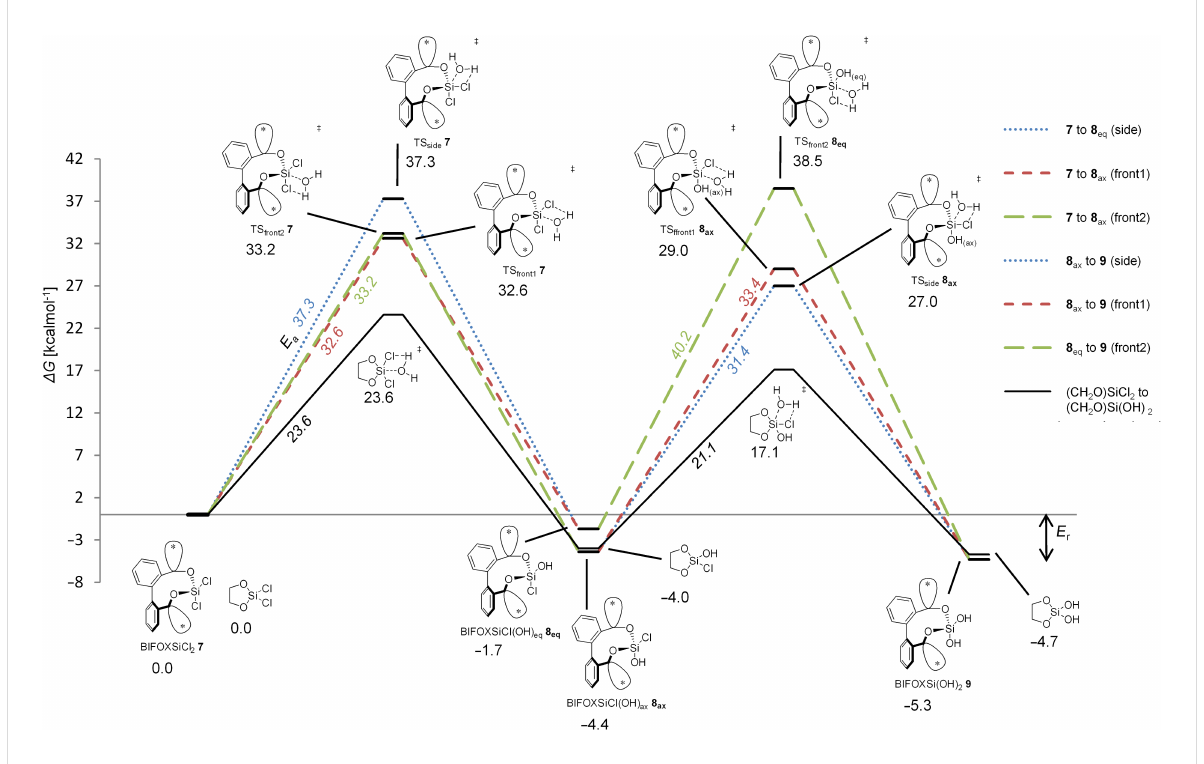
Figure 5: Computed hydrolyses of BIFOXSiCl 2 ( 7 ) to BIFOXSiCl(OH) 8 ax and BIFOXSiCl(OH) 8 eq and subsequent computed hydrolysis to BIFOXSi(OH) 2 ( 9 ) and comparison with glycoxydichlorosilane. The activation energy ( E a ) is the difference of the free Gibbs energy of the educt and the TS and the reaction energy ( E r ) is the difference the free Gibbs energies of the educts and products of the respective steps side and front1 result- ing in BIFOXSiCl(OH) 8 eq , front2 results in BIFOXSiCl(OH) 8 ax . From BIFOXSiCl(OH) 8 eq only front2 is a possible path to BIFOXSi(OH) 2 ( 9 ). From BIFOXSiCl(OH) 8 ax front1 and side are possible paths to BIFOXSi(OH) 2 ( 9 , Table 3, Figure 4, Scheme 5). Reaction energies are ( E r ) in kcal mol − 1 , activation energies are ( E a ) in kcal mol − 1 and italic.